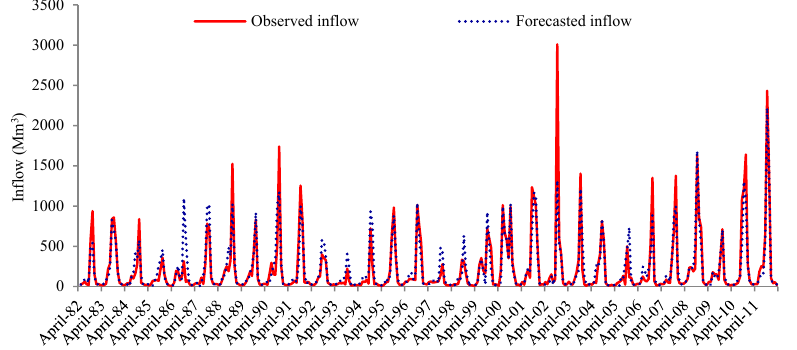
Figure 5. Time series of 1-month ahead of observed and forecast inflows for the complete data record. Table 1. Summary of evaluated reservoir performance indices for Ubonratana